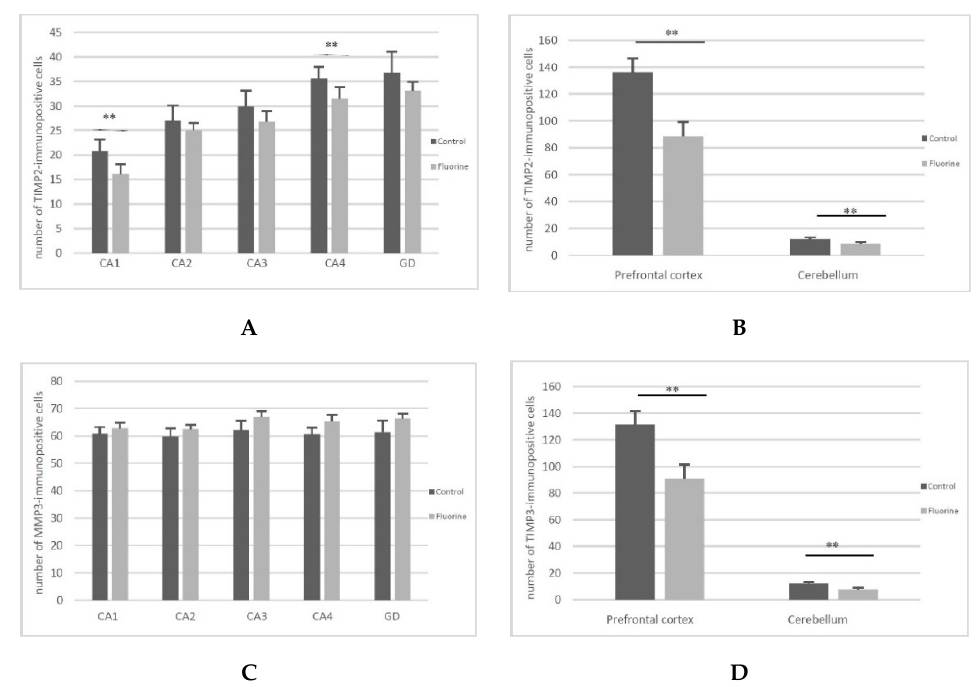
Figure 6. The number of TIMP2-immunopositive cells in the hippocampus ( A ) and in the prefrontal cortex and cerebellum ( B ) and the number of TIMP3-immunopositive cells in the hippocampus ( C ) and in the prefrontal cortex and cerebellum ( D ). * p ≤ 0.05, ** p ≤ 0.005, *** p ≤ 0.001 (Mann– Whitney U test), n = 6.